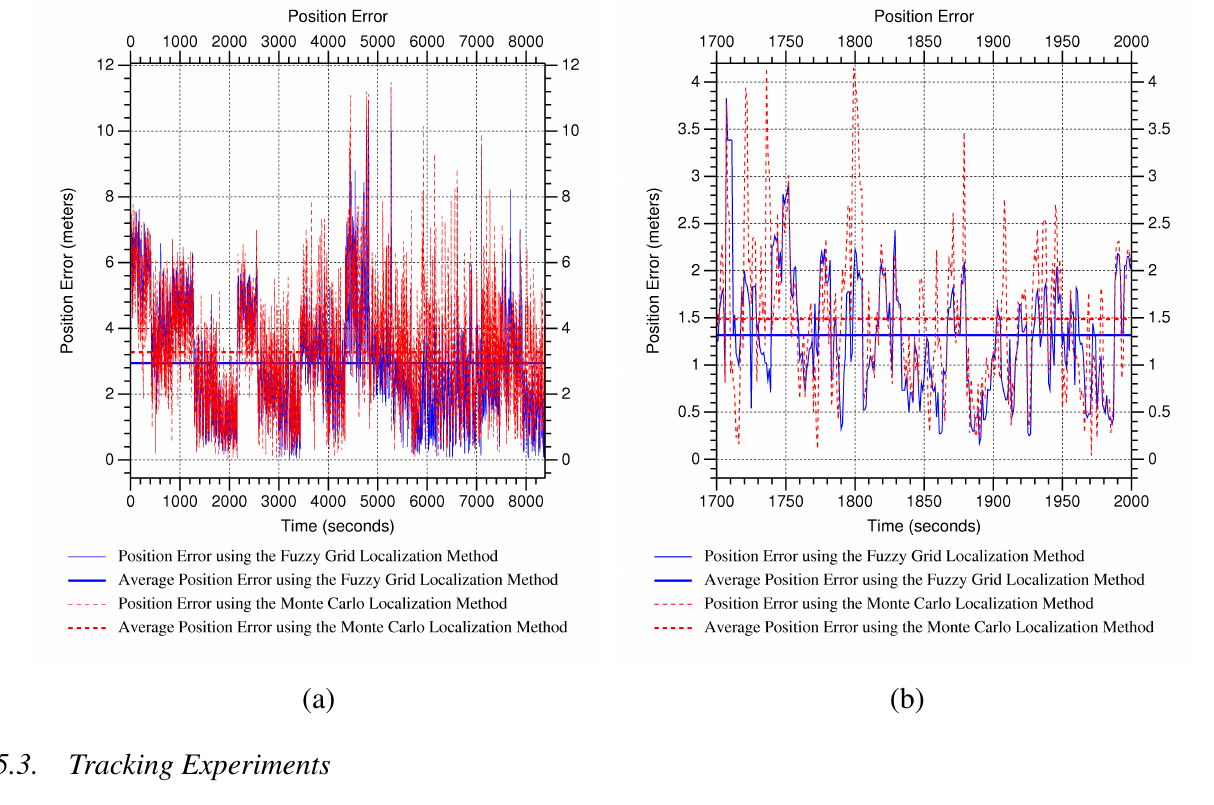
Figure 8. Position error in kidnapping experiment: (a) long and (b) short series. Note that the peaks of position error correspond to the instant after the sensor node is